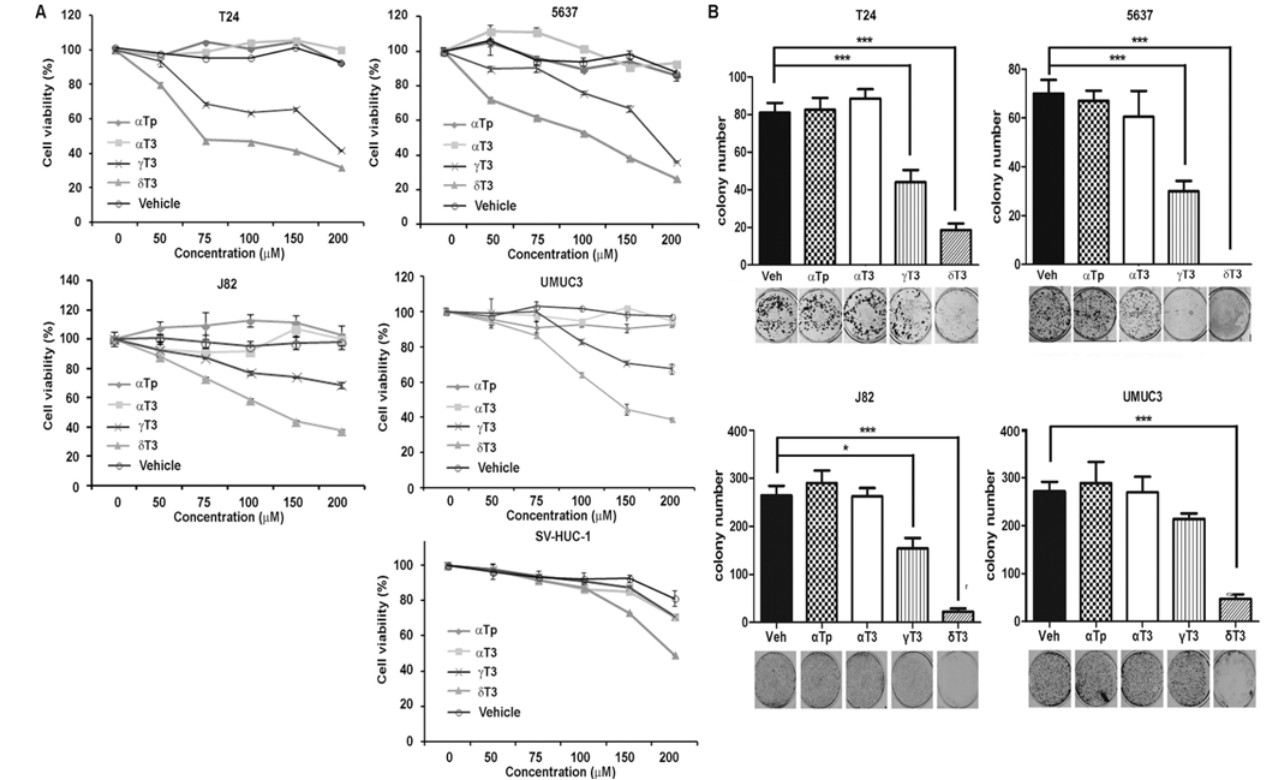
Fig 1. Effects of vitamin E isomers on bladder cancer cells. (A) Human bladder cancer cells T24, 5637, J82 and UMUC-3, as well as non-malignant human urothelial SV-HUC-1 cells were treated with each vitamin E isomers ( α -TP, α -T3, γ -T3 and δ -T3) ranging from 0 to 200 μ M for 72 h, and cell viability were detected by MTT assay. (B) Colony formation assay of T24 5637, J82 and UMUC-3 cells with 100 μ M α -TP, α -T3, γ -T3 and δ -T3 for 14 days. Vertical bars indicate the mean cell count ± SD in each treatment group. * , P < 0.05; *** , P < 0.001, compared to vehicle treatment group.